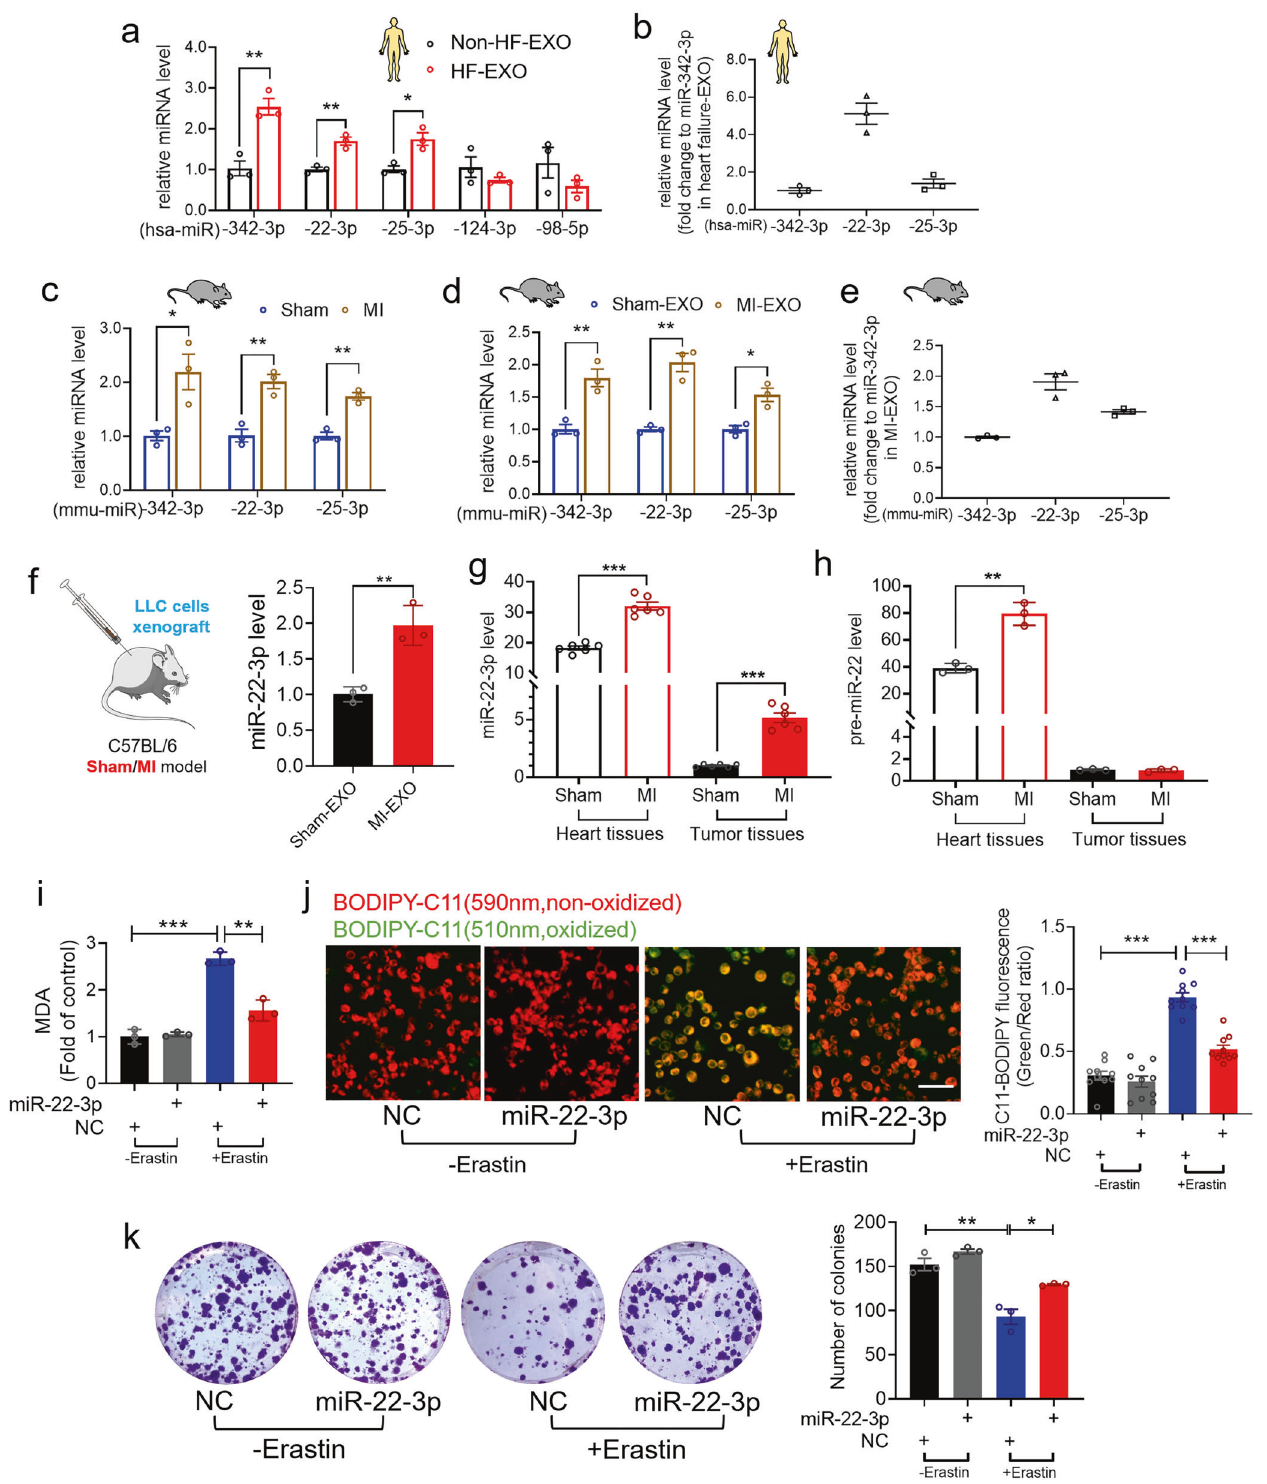
(NC) in the absence of erastin. On the contrary, inhibition of miR- 22-3p by its antisense oligonucleotide sequence (AMO-22-3p) produced the opposite effects (Supplementary Fig. 7). AMO-22-3p increased MDA production and lipid-ROS accumulation and suppressed colony-forming ability in the presence of erastin. Little difference was observed between NC and AMO-22-3p for